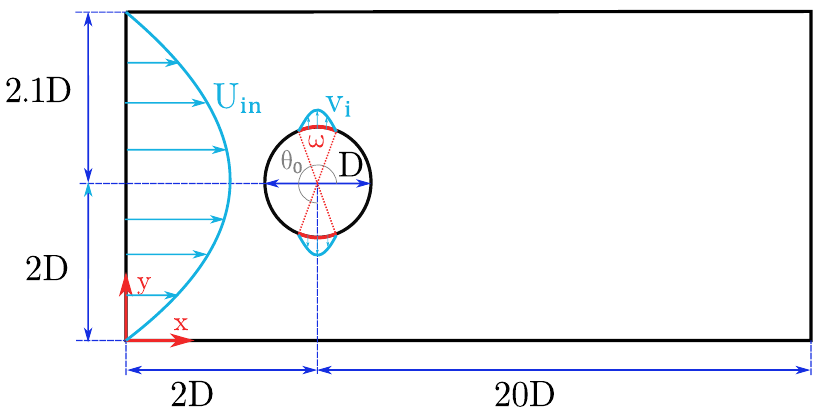
Figure 1. Main domain dimensions in terms of the cylinder diameter D , where ω represents the jet width and θ 0 is the angle of the center of the jet. In light blue, the parabolic velocity profile of the inlet and the jet are represented. The domain representation is not to